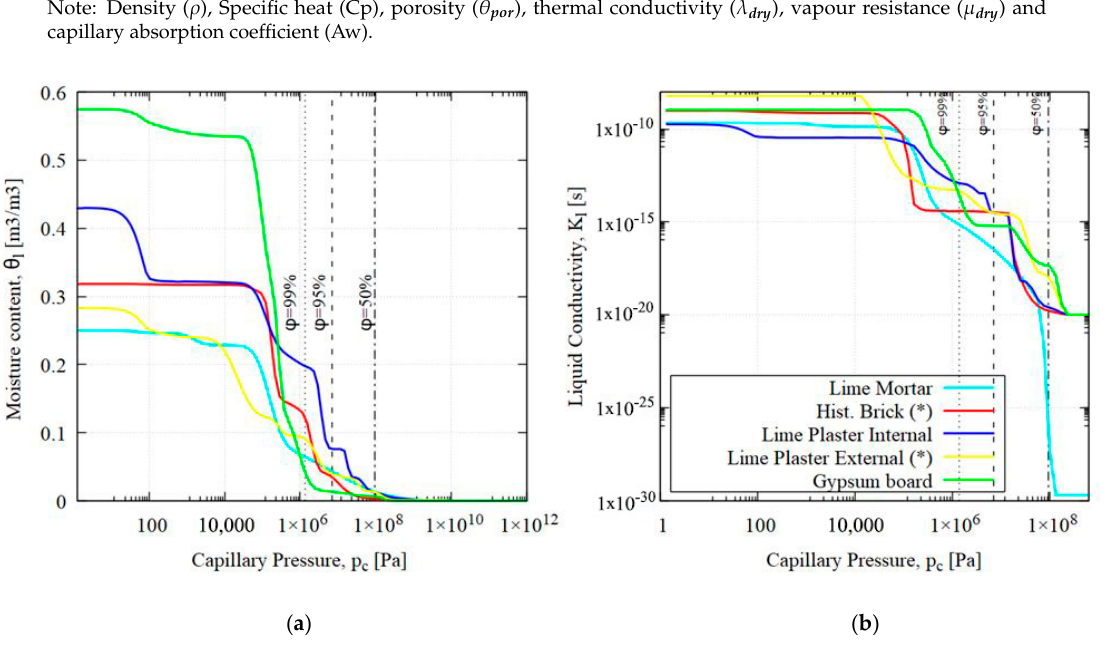
Figure 10. Moisture storage function of the materials used for the 2D simulation.